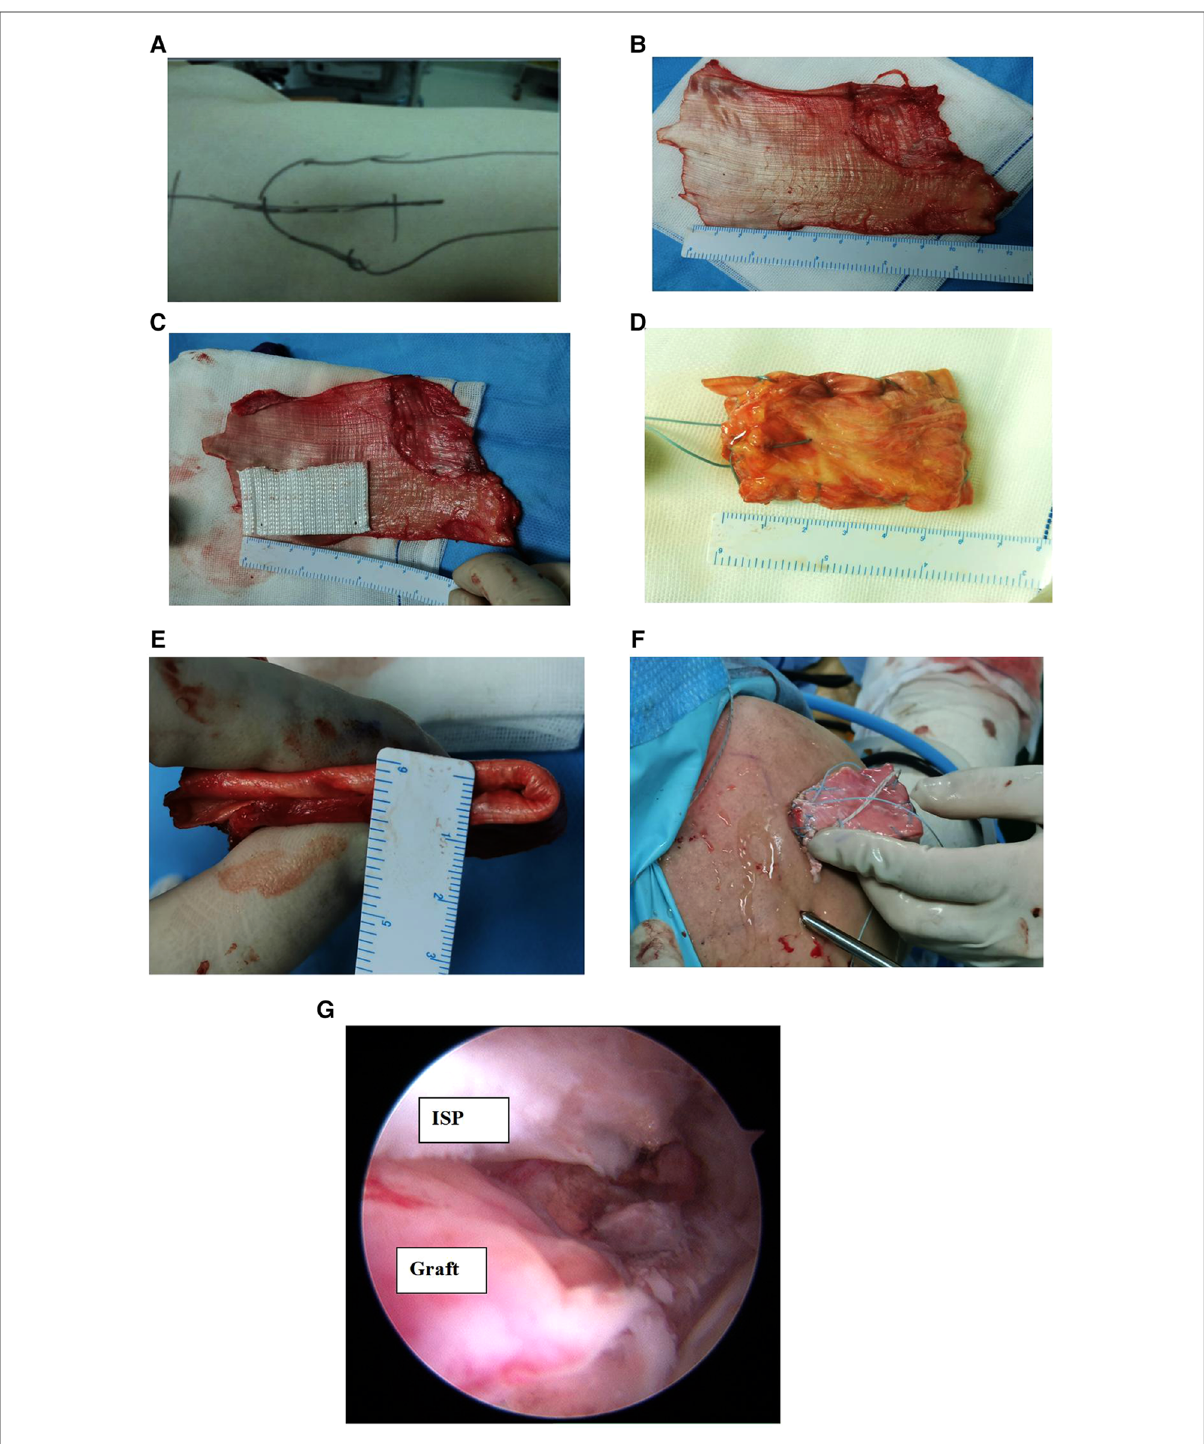
FIGURE 3 Intraoperative radiograph of arthroscopic superior capsule reconstruction. ( A ) Vertical skin incision; ( B ) harvested section of the fascia lata, two times the size of the superior capsular defect; ( C ) folding the fascia lata in half, combined with a pet material; ( D, E ) weaving the four sides with a non- absorbable suture to make a fascia lata patch, on which a graft 5.5 – 6.0 cm in length and 6 – 8 mm in thickness was fashioned by folding the fascia lata twice thick; ( F ) insertion of the fascia lata into the subacromial space through the anterolateral portal; (G) arthroscopic superior capsule reconstruction. ISP, infraspinatus